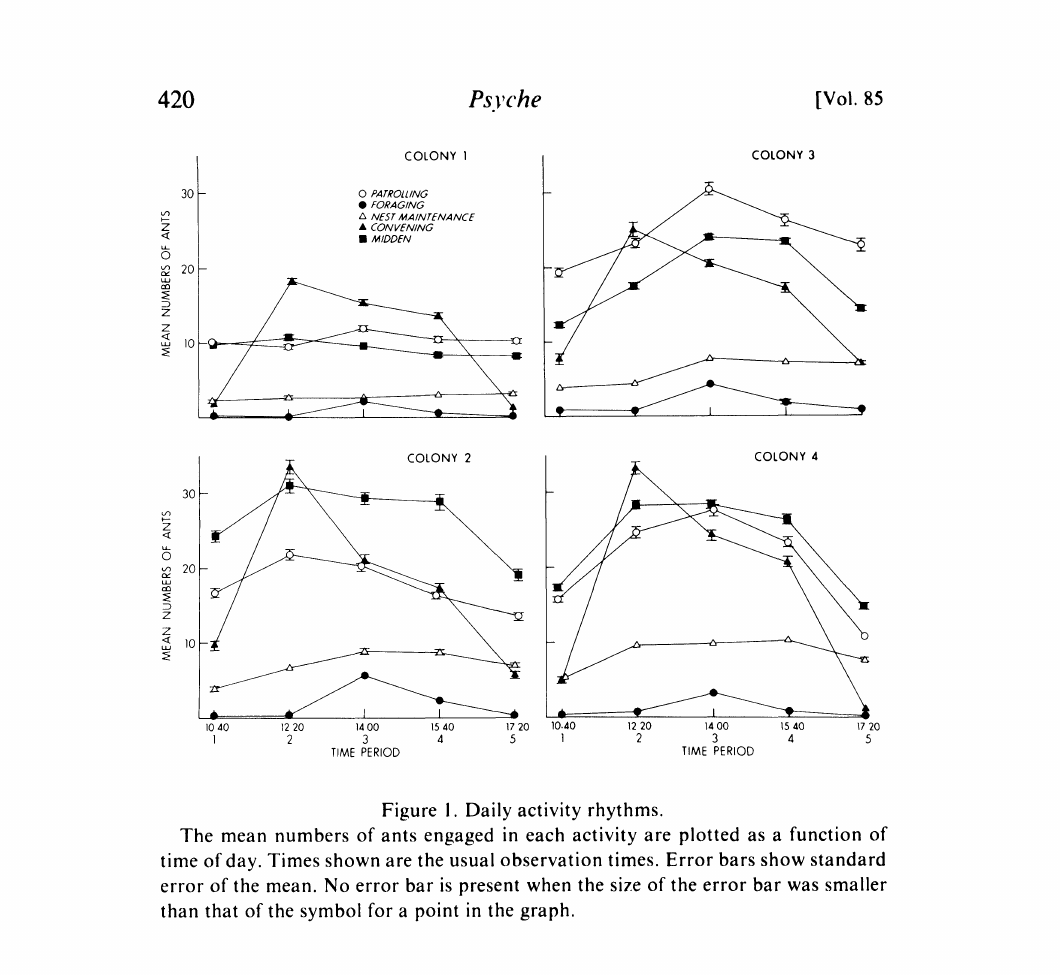
Figure I. Daily activity rhythms. The mean numbers of ants engaged in each activity are plotted as a function of time of day. Times shown are the usual observation times. Error bars show standard error of the mean. No error bar is present when the size of the error bar was smaller than that of the symbol for a point in the